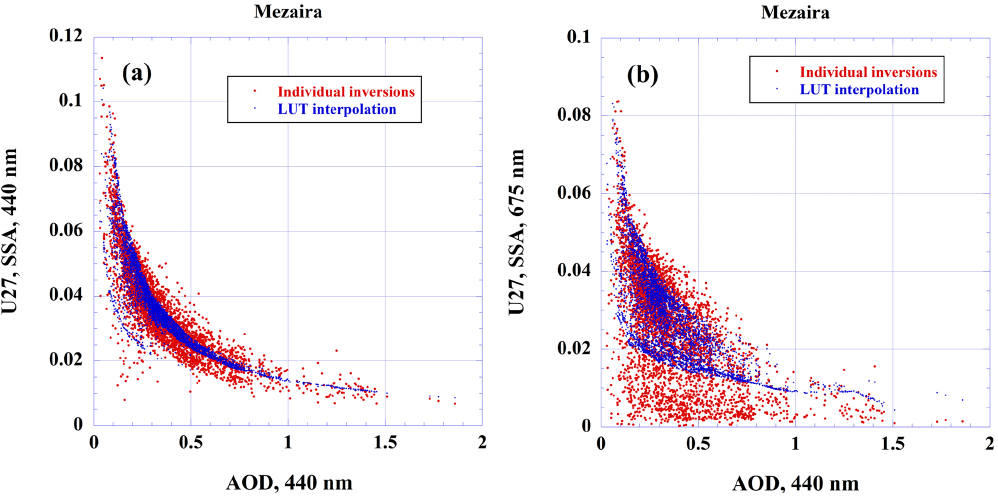
Figure 19. Comparison of SSA U27 estimated for individual inversions and by interpolation over LUT for the Mezaira site: (a) 440; (b) 675nm.